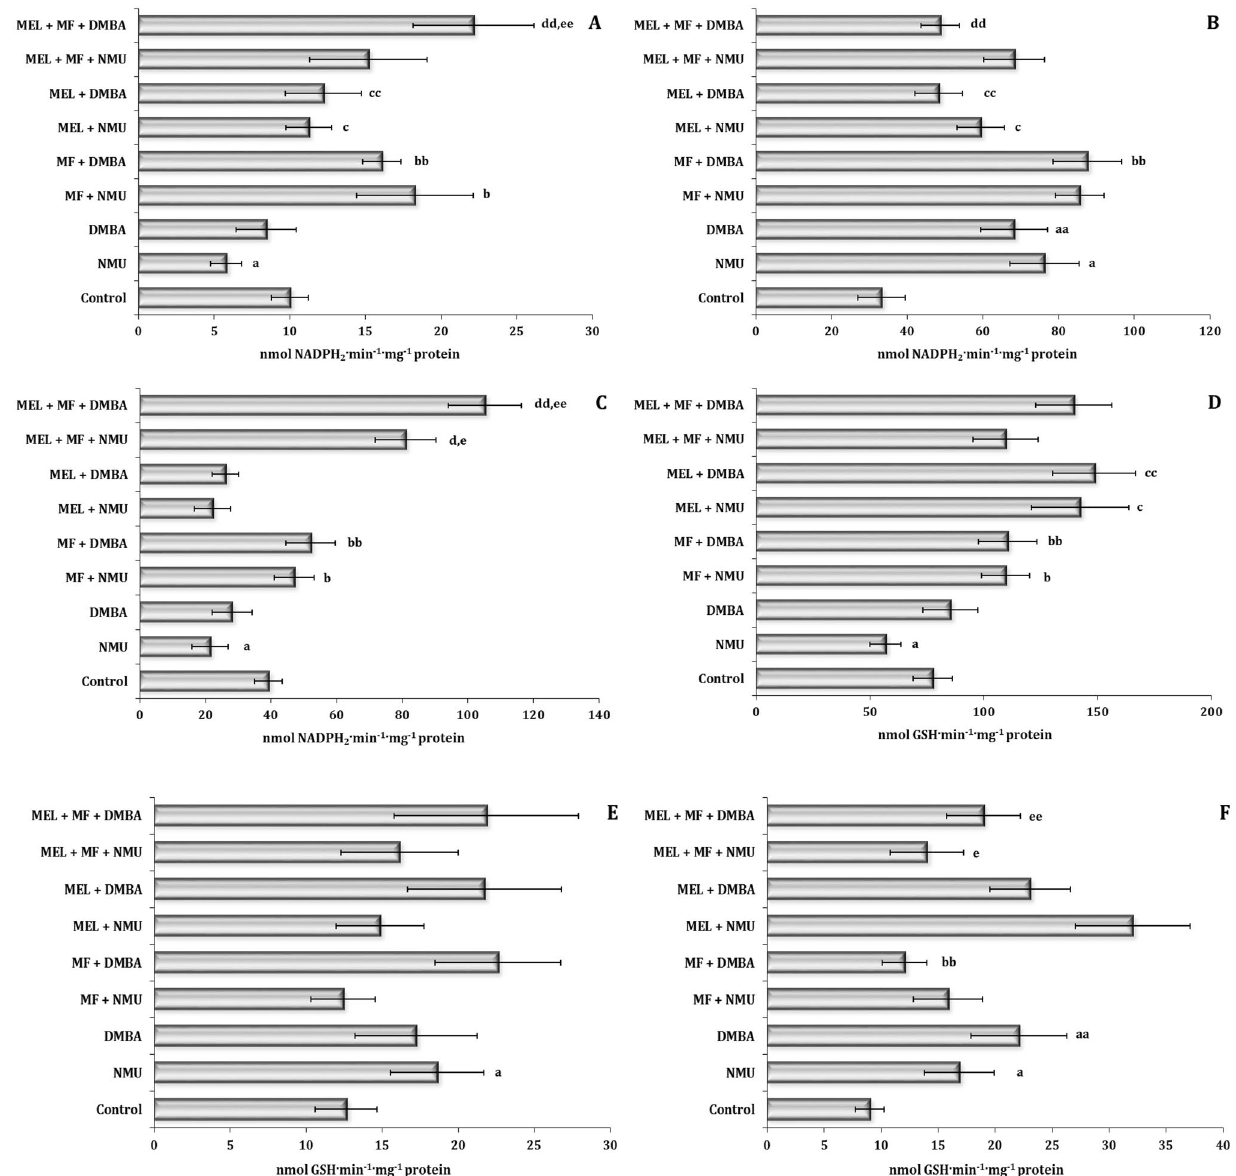
Figure 3. Glutathione reductase activity (nmol NADPH 2 ·min −1 ·mg −1 protein) in the liver ( A ), heart ( B ) and spleen ( C ) and glutathione peroxidase activity (nmol GSH ·min −1 ·mg −1 protein) in the liver ( D ), heart ( E ) and spleen ( F ) of female Sprague–Dawley rats subjected to a high-fat diet in the mammary carcinogenesis model induced by N -methyl- N -nitrosourea (NMU) or dimethylbenzanthracene (DMBA). Metformin (MF) or melatonin (MEL) was administrated alone and in combination (MF + MEL). Data are expressed as means ± S.D. Significant differences P < 0.05 are designated as follows: a—NMU group vs. control group; aa—DMBA group vs. control group; b—MF + NMU vs. NMU group; bb—MF + DMBA vs. DMBA group; c—MEL + NMU vs. NMU group; cc—MEL + DMBA vs. DMBA group; d—MEL + MF + NMU vs. MF + NMU group; dd—MEL + MF + DMBA vs. MF + DMBA group; e—MEL + MF + NMU vs. MEL + NMU group; ee— MEL + MF + DMBA vs. MEL + DMBA group. NMU, N -methyl- N -nitrosourea; DMBA, dimethylbenzanthracene; MF, metformin; MEL,